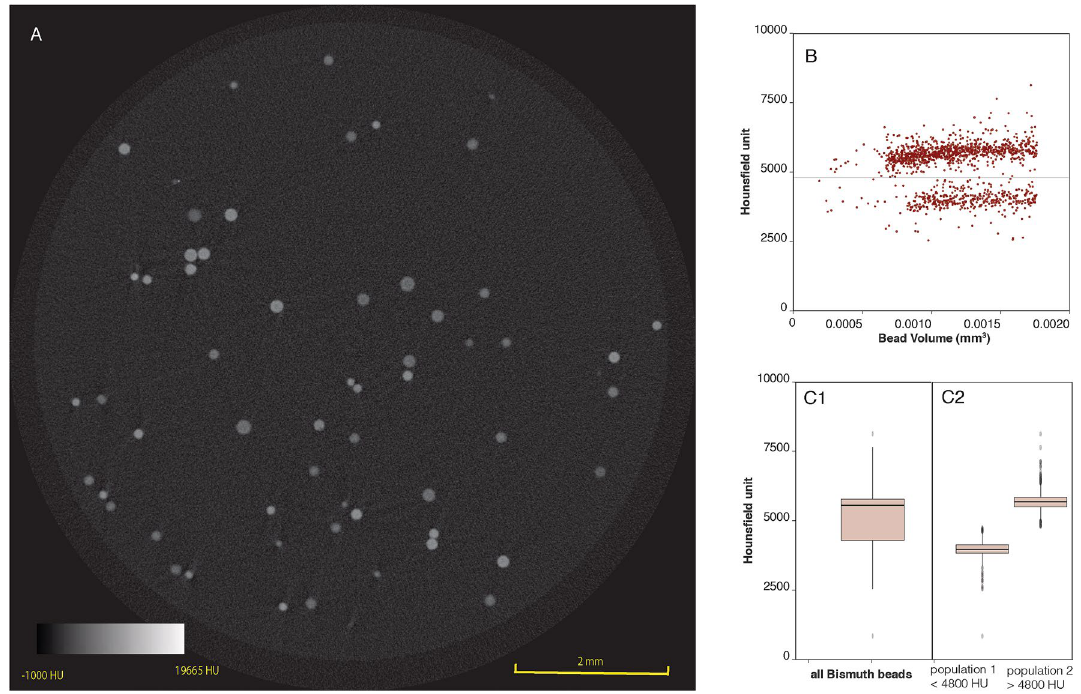
Figure 4. MicroCT imaging of bead 6 . ( A ) Axial slice of a suspension of bead 6 . ( B ) Scatterplot revealing two bead subpopulations that can be distinguished at a 4800 threshold. There was no correlation between bead volume and HU. ( C ) Boxplots of HU for all bismuth beads ranging 70–150 μm ( C1 ) and both bead populations ( C2 ) revealing the average intensity for both bead populations.